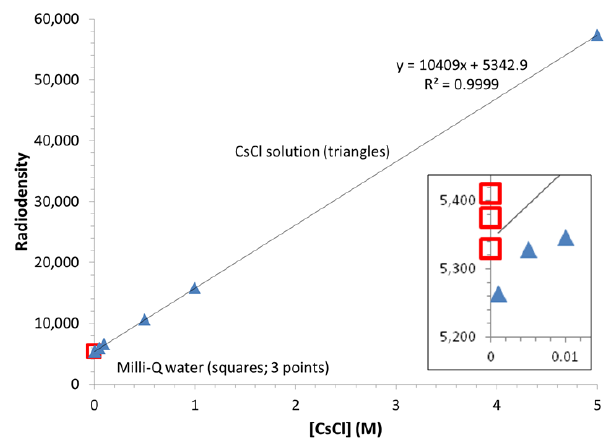
Figure 1. Radiodensity of pure water (red open squares, three data points) and of aqueous solutions containing CsCl (blue